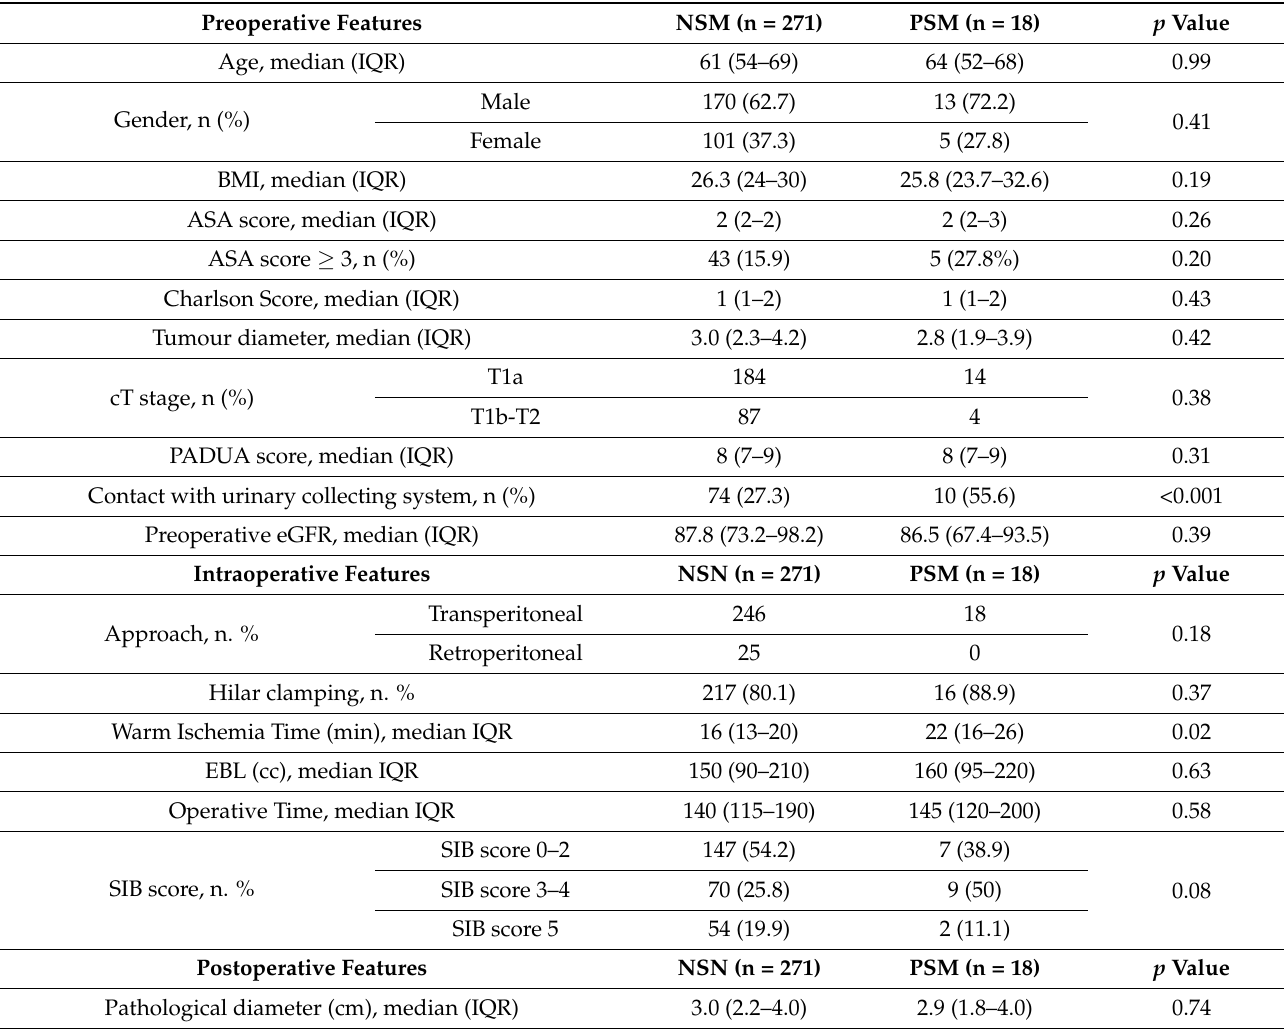
Table 3. Comparison of clinical, surgical and postoperative features according to surgical margin status in 289 patients treated with robotic PN for cT1-2N0M0 renal